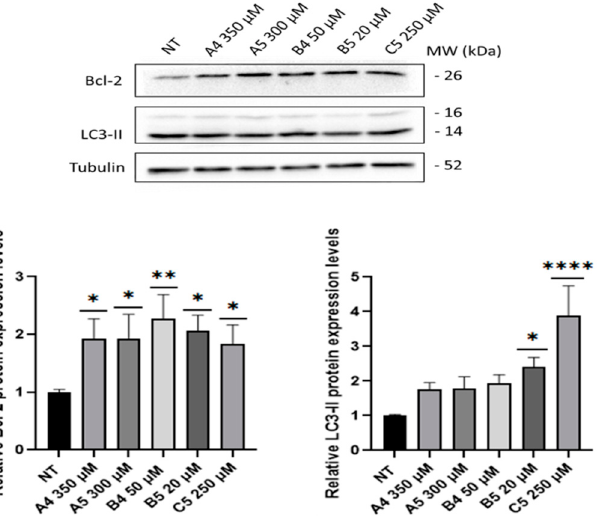
Figure 6. Bcl-2 and LC3-II levels in SUP-T1 cells at 4 h p.t. after GEs treatment: A4 = 350 µ M, A5 = 300 µ M, B4 = 50 µ M, B5 = 20 µ M and C5 = 250 µ M. All the proteins were analyzed through immunoblotting and relative densitometric analyses. Bcl-2 and LC3-II were normalized to housekeep- ing levels. Bcl-2 proteins were normalized to housekeeping levels. Normalized values are reported on Y -axis as arbitrary units. Molecular weights (MW) in kDa and SEM bars are shown. Asterisks indicated p < 0.05 (*), p < 0.01 (**), p < 0.0001 (****), compared with non-treated (NT) control cells